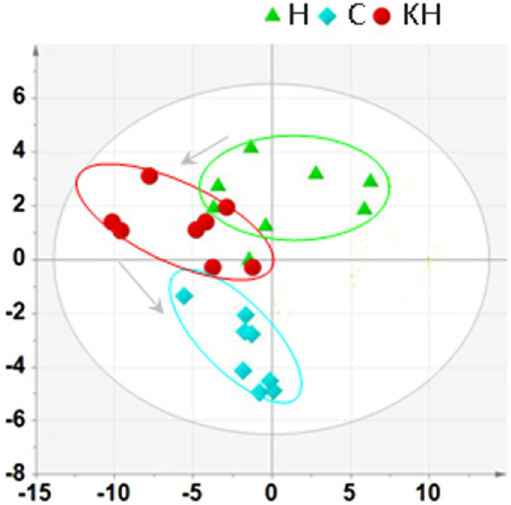
Figure 5. PCA scores plot of all samples in different groups. The blue square is the C group, the red dot is the H group and the green triangle is the KH group. C: control group; H: Heat stress group; KH group: Kisspeptin + Heat stress group.